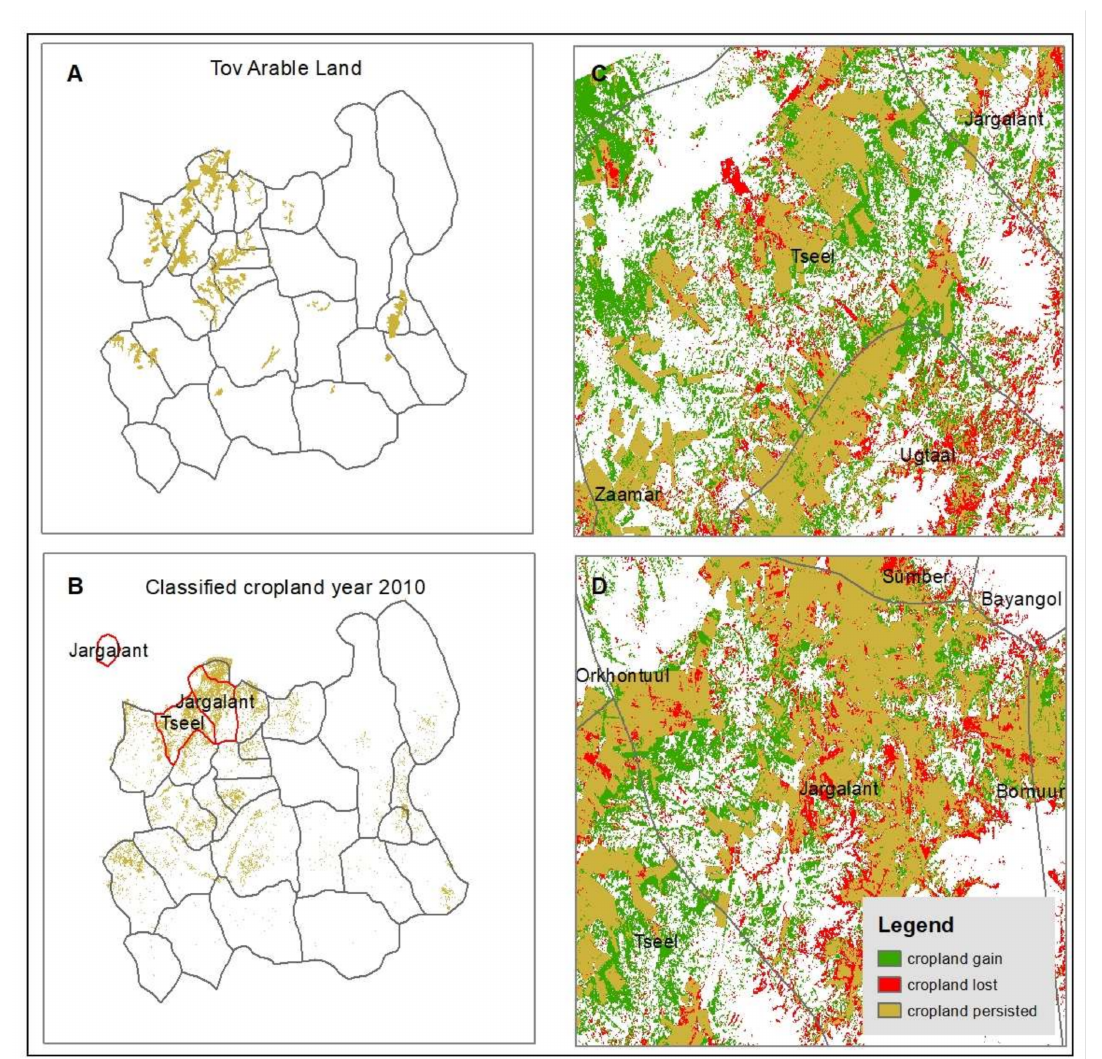
Figure 7. Spatial distribution of cropland. ( A ) Arable cropland distribution in Tov according to Mongolian government statistics; ( B ) classified cropland cover map of Tov in 2010 with highlighted counties having a large area of cropland; ( C ) cropland transition from 2000 to 2010 of county Tseel; and ( D ) cropland transition in Jargalant from 2000 to